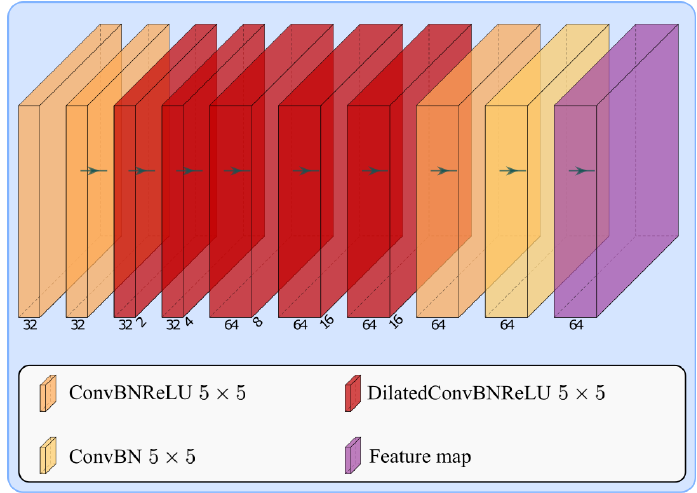
Figure 4. Siamese-CNN architecture. The dilation rate of the dilated convolutions is denoted along the z-axis. Abbreviations: Convolution (Conv), Batch Normalization (BN), Rectified Linear Unit